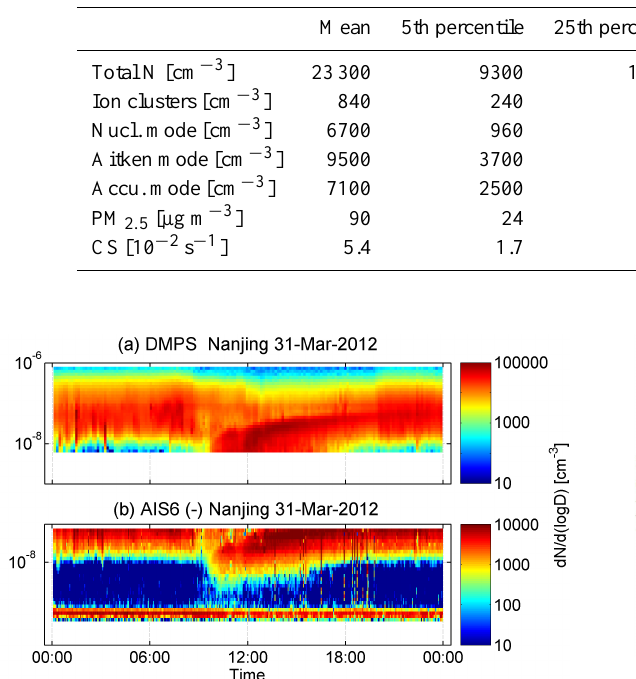
Fig. 5. (a) 1-day footprint retroplume for event days in a map of eastern China. The measurement site is marked by a white dot. (b) Observed nucleation probability at the site as a function of the di- rection of the incoming air